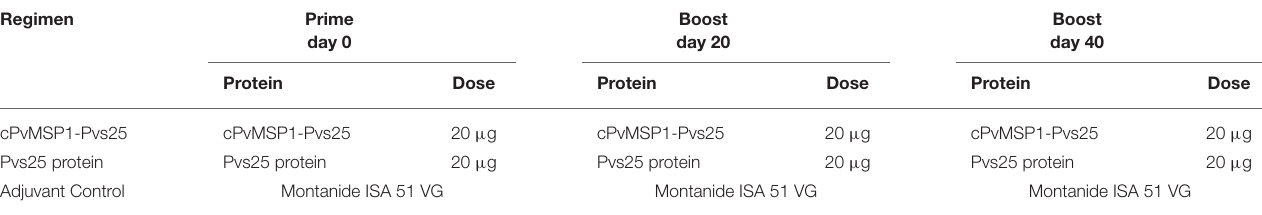
TABLE 2 | Immunization regimens.